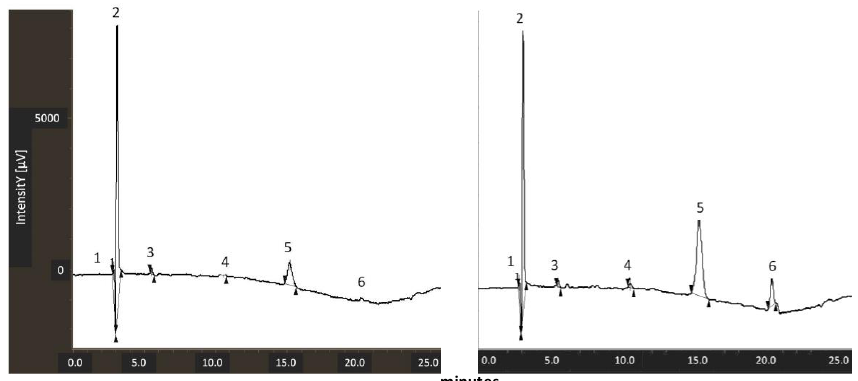
Figure 1. Cryo-TEM projection images of dryTom-Ne ( left ) and dryTom-Ne-CT ( right ).